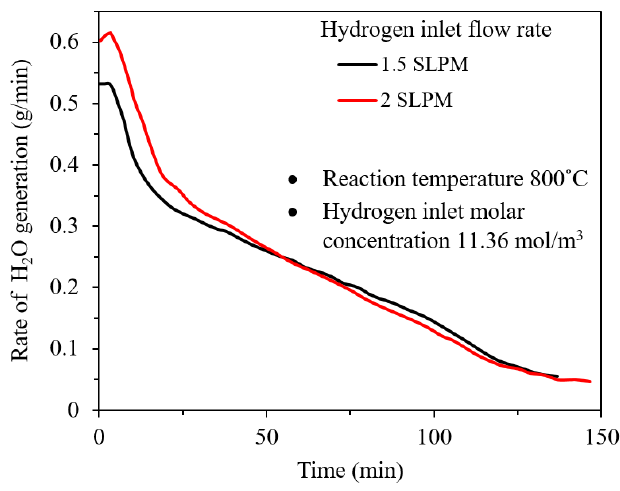
Figure 7. Rate of steam generation during the reduction for a hydrogen inlet flow rate of 1.5 and 2.0 SLPM at 800 °C [23] “modified” .